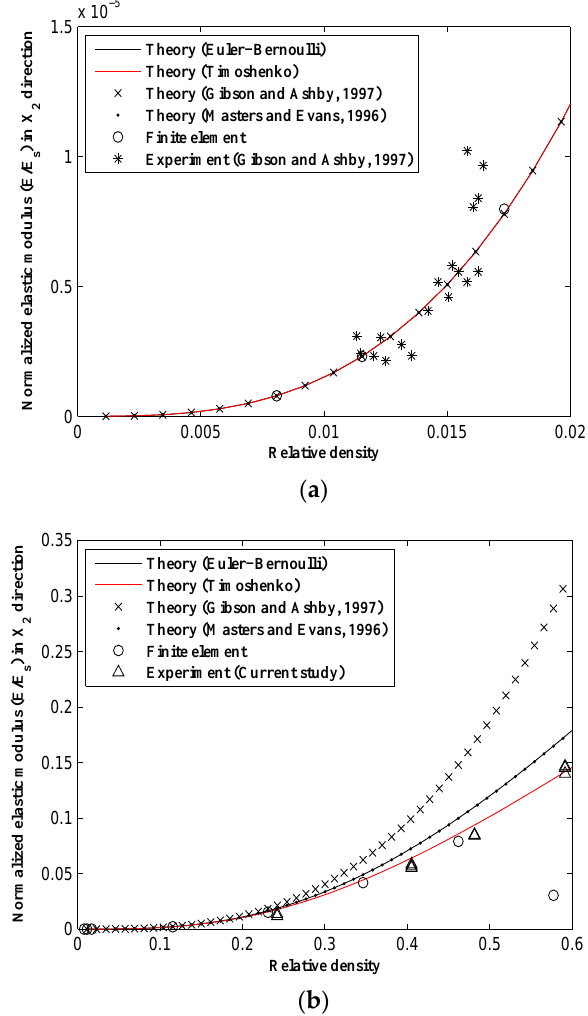
Figure 11. Variation of relative elastic modulus in X 2 direction ( E 2 { E s ) vs. relative density ( ρ { ρ s ) for analytical, experimental, and numerical results. ( a ) For small relative density range; and ( b ) for the complete range of relative density.